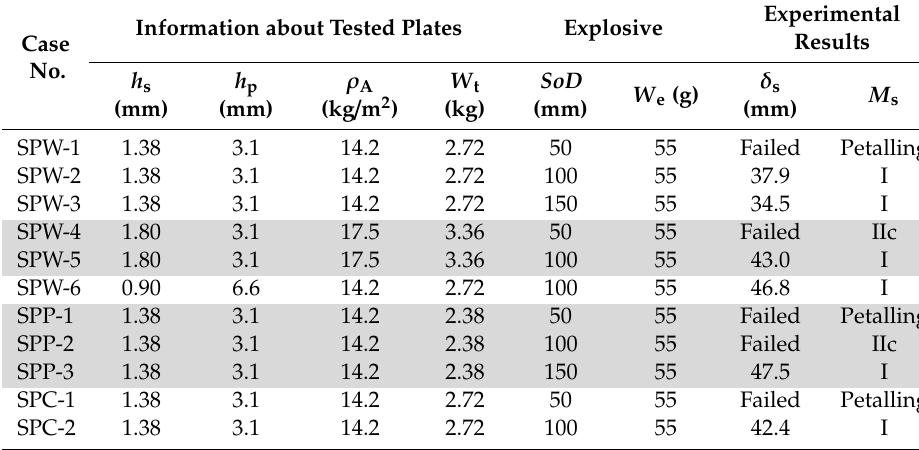
Table 3. Detailed information regarding the experimental results for polyurea ‐ coated steel plates in the present study.